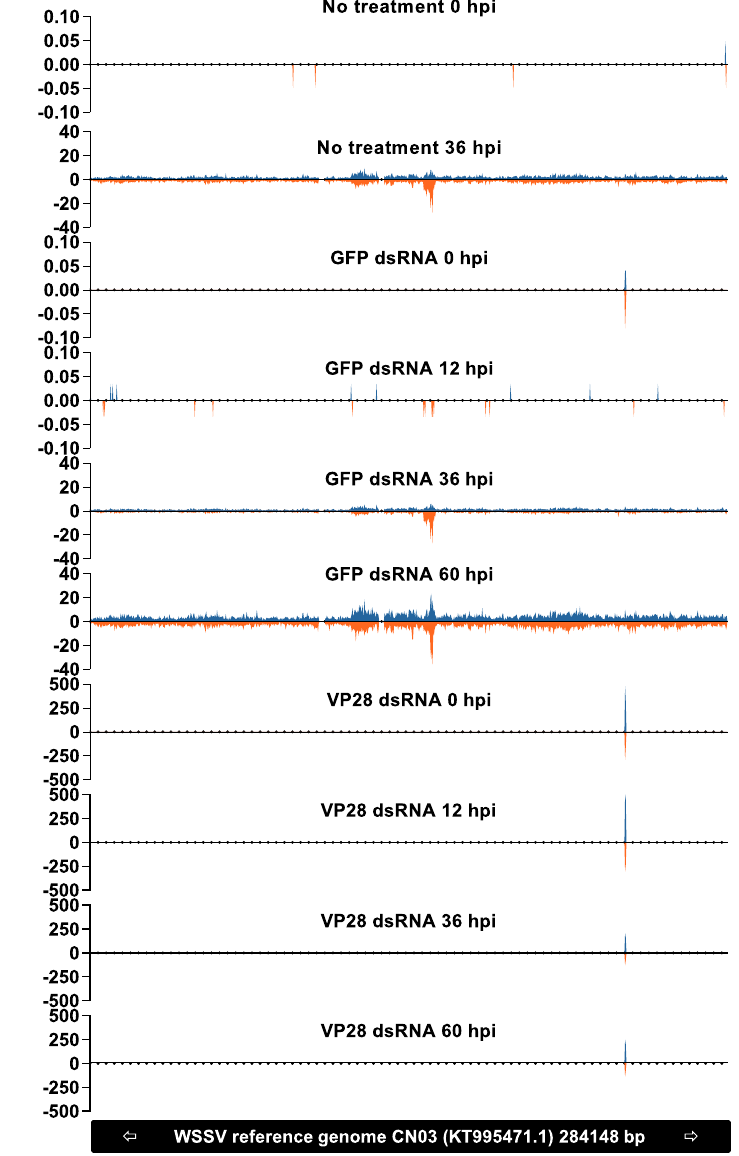
Figure 11. The frequency of 22 nt siRNAs per 300 bp bin across a reference WSSV genome is shown to emphasize the difference between a natural RNAi response to WSSV infection in comparison to a VP28 dsRNA induced siRNA response. RNA was isolated from stomach tissue and equal amounts were pooled for each sample within a given group at a given time point. RNA sequencing was performed on these pools and 22 nt long siRNAs were filtered out to be analyzed separately. The Y-axis represents reads per million total reads for a given sample (RPM), and positive and negative values indicates forward- and reverse mapping siRNAs